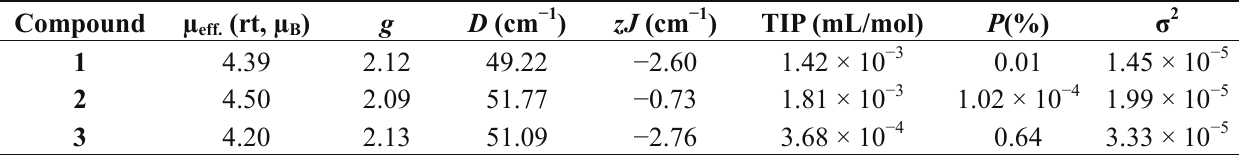
Table 3. Magnetic parameters obtained in the fits of the magnetic moment as a function of temperature for compounds 1 – 3 .